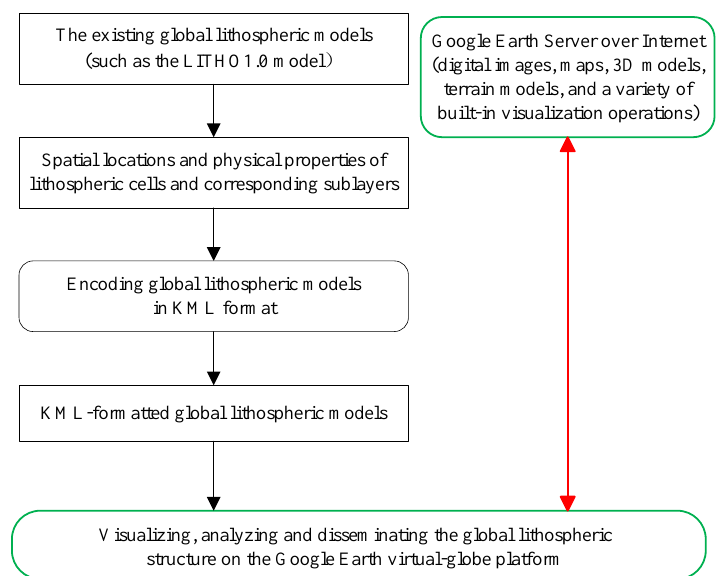
Figure 2. Overall framework for the representation, visualization, and dissemination of the structure of the Earth’s lithosphere on the Google Earth virtual globe platform.